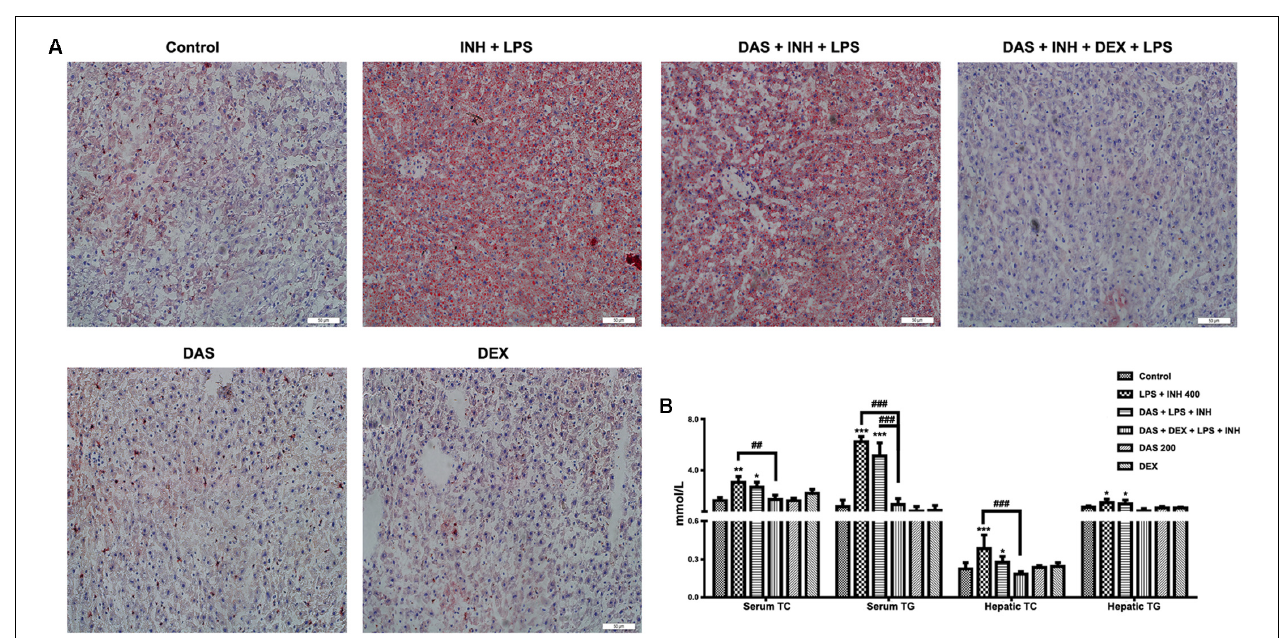
FIGURE 3 | Analysis of lipid profile following drug treatment. (A) Lipid staining in rat livers. Frozen liver sections were subjected to Oil Red O staining; massive steatosis seen in rats received INH/LPS co-treatment with or without DAS administration, whereas combination of DAS and DEX decreased hepatic lipid accumulation. (B) Variation in both serum and hepatic lipid profile. Data are represented as mean ± SD, n = 7 for each bar. ∗ P < 0.05, ∗∗ P < 0.01, ∗∗∗ P < 0.001 versus control, ## P < 0.01, ### P < 0.001 versus INH/LPS or DAS/INH/LPS combination.